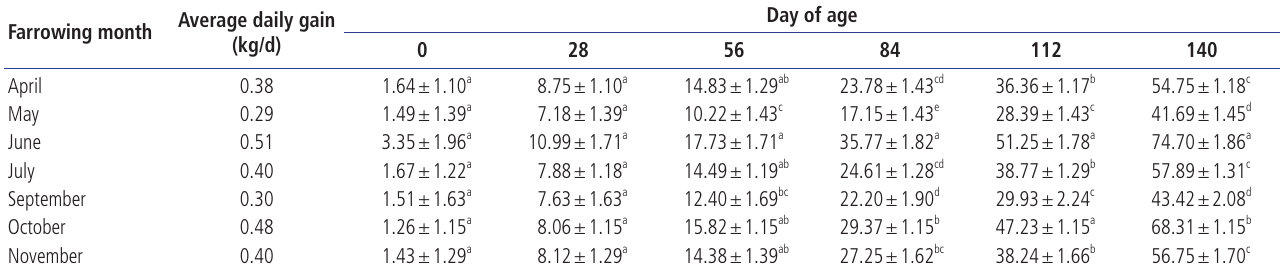
Table 4. Least square means and standard errors for piglet growth performance by farrowing month Average daily gain Farrowing month (kg/d)